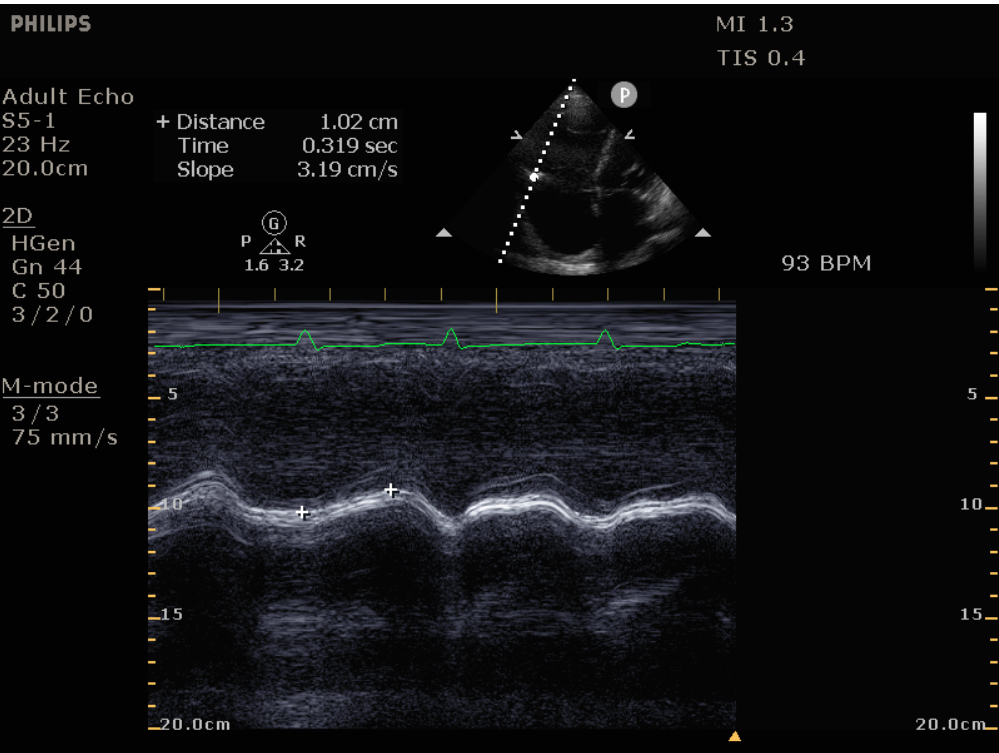
Figure 6. Measurement of tricuspid annular plane systolic excursion (TAPSE) as a measure of RV systolic function. Values < 17 mm are considered pathological (here 10 mm).